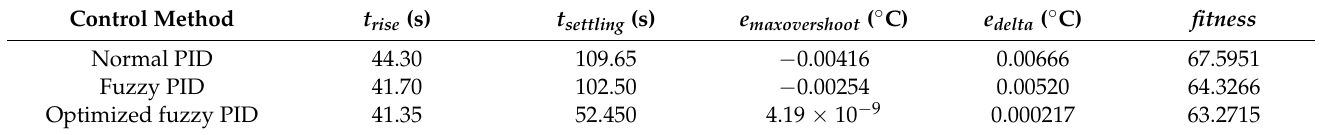
Figure 8. Temperature control performance. ( a ) Comparison of applying three methods; ( b ) red dashed box part of ( a ) enlarged. Table 5. Comparison of temperature control results applying three